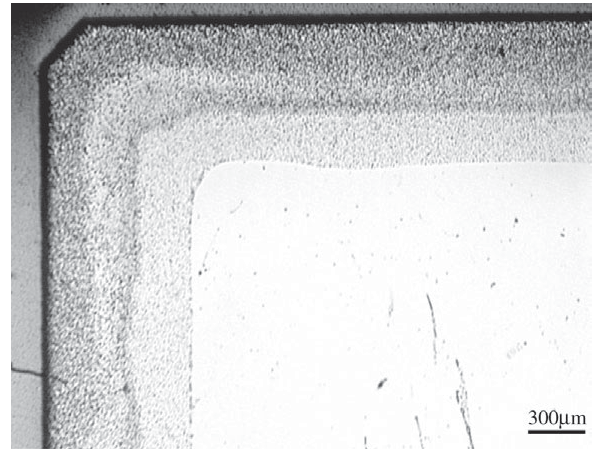
Figure 4. Cross section of Si H SO at 90 °C in reflected polarised light microscopy from 43 . 2 4